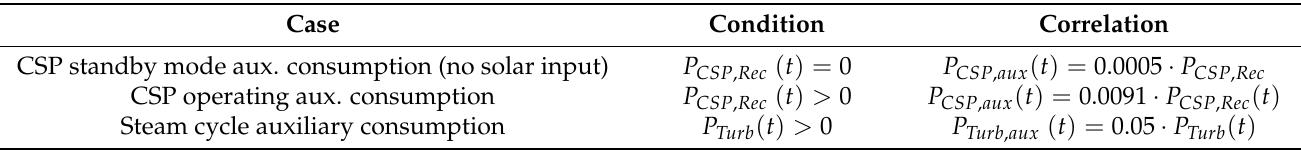
Table 4. CSP and steam cycle auxiliary electricity consumption.